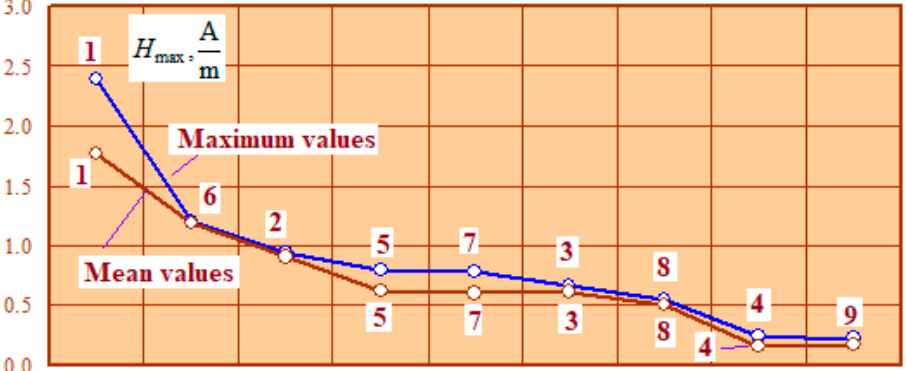
Figure 22. Maximums and mean values amplitudes of the magnetic field at the starting end of the transmission line 5—callout numbers correspond to those in Figure 15.